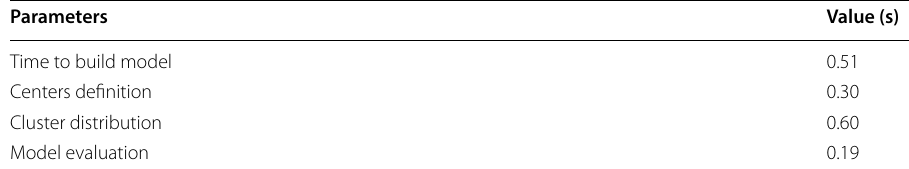
Table 8 Performance of k-means algorithm